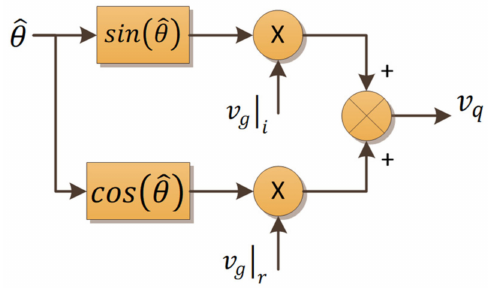
Figure 15. Block diagram for the implementation of the Park transformation.